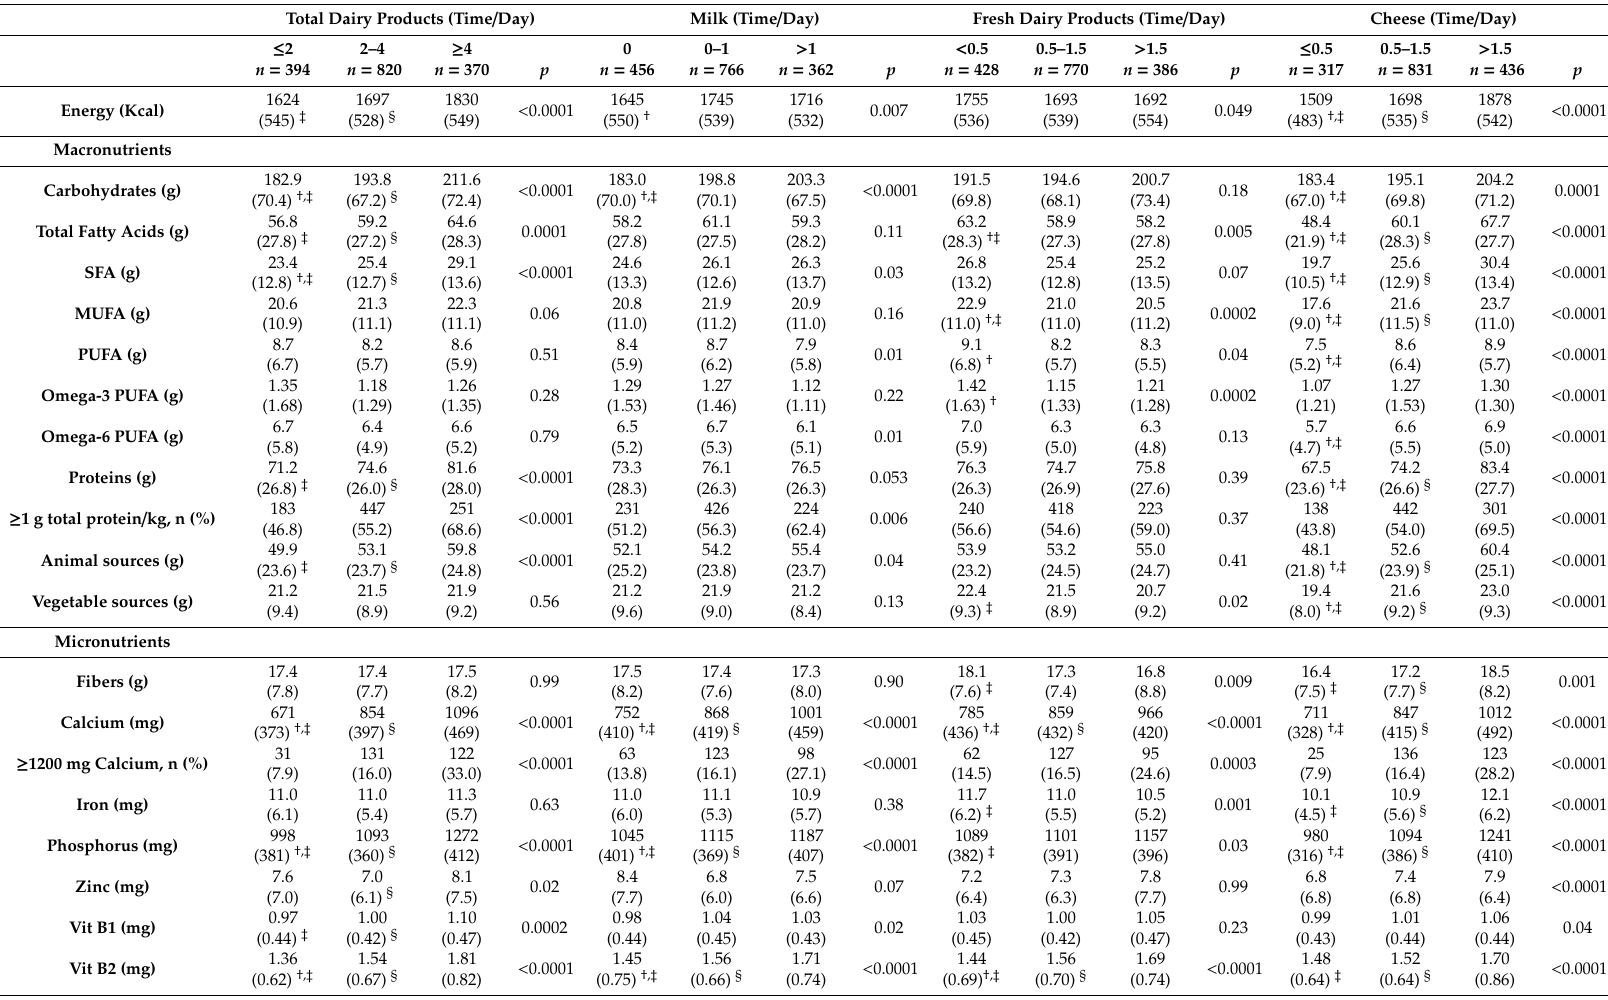
Table 2. Daily energy, macro- and micro-nutrient intakes across increasing daily frequency consumption of dairy products among elderly community dwellers from the 3C study, Bordeaux (France), 2001–2002, n =